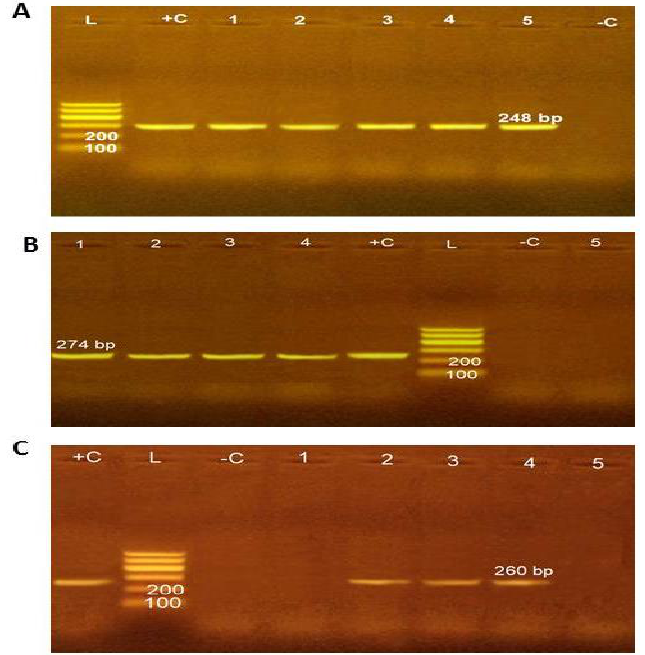
Figure 1. Molecular characterization of S. typhimurium virulence genes. ( A ) Salmonella typhimurium - InvA gene in 1.5% agarose gel (L: 100 bp ladder; − C: negative control; +C: positive control, from 1 to 5: Salmonella positive isolates for InvA gene). ( B ) Salmonella typhimurium SdiA gene in 1.5% agarose gel (L: 100 bp ladder; − C: negative control; +C: positive control; 1.2.3.4 Salmonella positive isolates; 5: negative Salmonella for SdiA ). ( C ) Salmonella typhimurium Stn gene in 1.5% agarose gel (L: 100 bp ladder; − C: negative control; +C: positive control; 2.3.4 Salmonella positive isolates; 1,5: negative Salmonella for Stn ). (Positive control: ATCC 43971, Negative control: PCR mixture without DNA